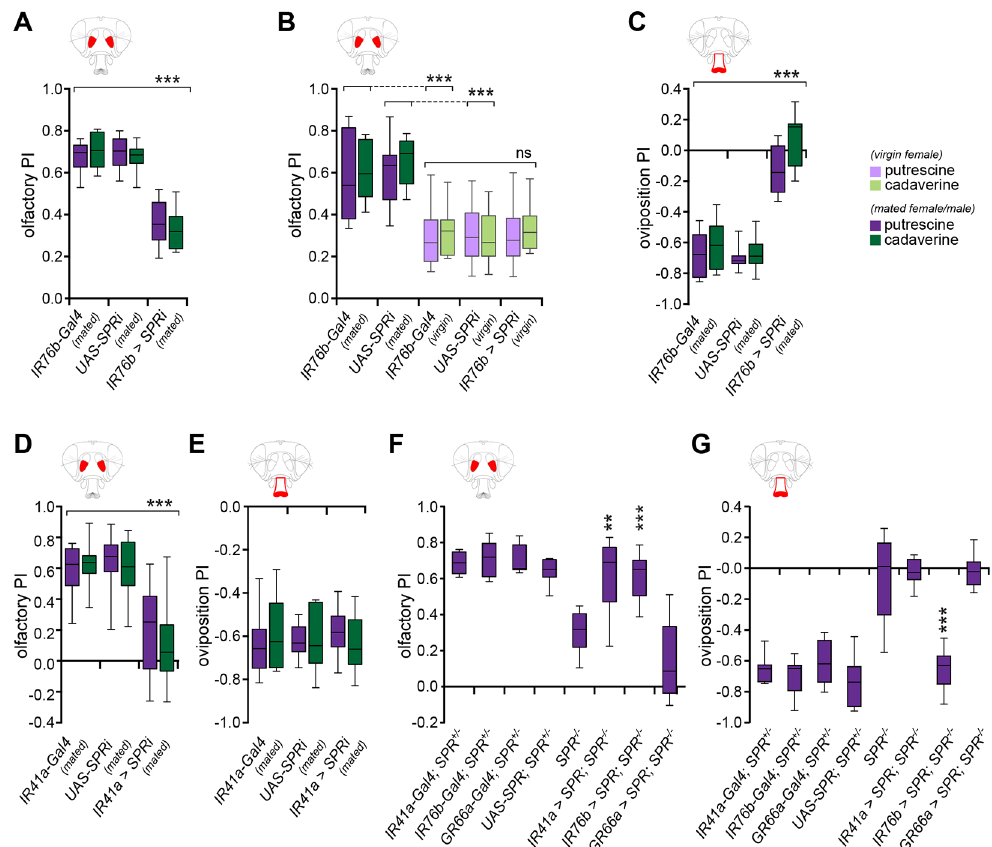
Fig 2. GPCR signaling in chemosensory neurons modulates female perception. (A) Knockdown of SPR in IR76b polyamine chemosensory neurons using RNAi ( IR76b-Gal4;UAS-SPRi ) significantly reduces olfactory preference to 10 ppm putrescine or cadaverine in mated females as compared to mated controls. ( n = 8, 60 mated ( ♀ ) flies/trial). (B) The effect of SPRi in IR76b neurons is mating state-dependent, as knockdown of SPR ( IR76b-Gal4;UAS-SPRi ) does not further decrease the olfactory attraction of virgin females to polyamines compared to control virgins. ( n = 8, 60 mated ( ♀ ) or virgin ( ☿ ) flies/trial). (C) Oviposition avoidance of a 1 mM polyamine/agarose substrate compared to a plain agarose substrate is strongly reduced upon knockdown of SPR in IR76b neurons ( IR76b-Gal4;UAS-SPRi ) ( n = 8, 60 mated ( ♀ ) flies/trial). (D) Knockdown of SPR in IR41a neurons ( IR41a-Gal4;UAS-SPRi ) leads to a similar decrease in attraction to the odor of polyamine (10 ppm) in the T-maze as compared to knockdown of SPR with IR76b-Gal4, suggesting that SPR is required in olfactory neurons to enhance the attraction of mated females to the polyamine odors ( n = 8, 60 mated ( ♀ ) flies/trial). (E) Knockdown of SPR in IR41a neurons ( IR41a-Gal4;UAS-SPRi ) did not affect oviposition behavior, and female behavior remained like their genetic controls. This result is consistent with the lack of expression of IR41a in taste neurons. (F) Re-expression of SPR using either IR41a-Gal4 or IR76b-Gal4 neurons fully rescued the SPR mutant phenotype of mated females in olfaction behavior to 10 ppm polyamines. ( n = 8, 60 flies/trial). (G) Re-expression of SPR in IR76b taste neurons using IR76b-Gal4 fully rescued the SPR mutant phenotype of mated females in oviposition behavior. Conversely, re-expression of SPR in IR41a olfactory neurons or GR66a bitter taste neurons did not rescue oviposition preference behavior. ( n = 8, 60 flies/trial). Box plots show median and upper/lower quartiles. All p -values were calculated via two-way ANOVA with the Bonferroni multiple comparison post-hoc test (ns > 0.05, * p (cid:1) 0.05, ** p (cid:1) 0.01, *** p (cid:1)